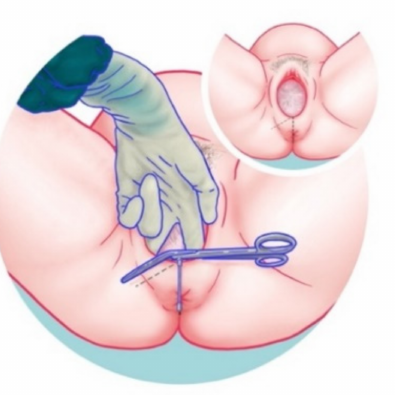
Figure 1. Acknowledged risk factors for the development of OASIS.